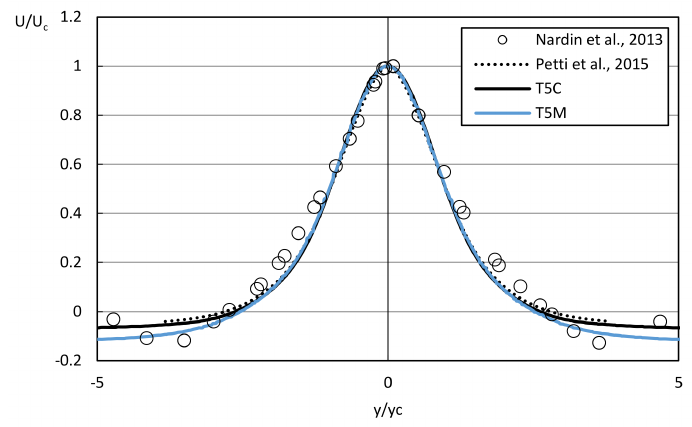
Figure 9. Normalized longitudinal velocity, in a cross section taken at 780 m from the jet inlet in the case of jet with the superimposed wave propagation with a period of 5